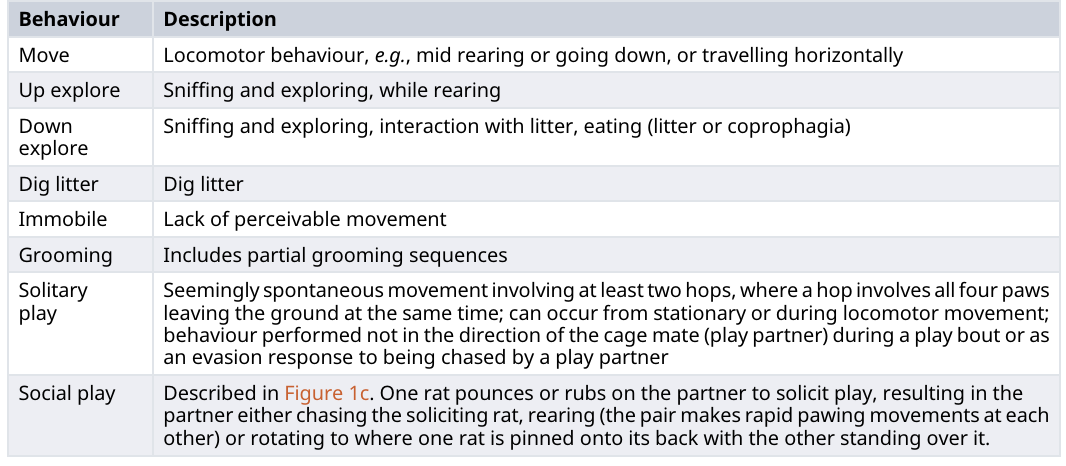
Table1.Ethogramforstudyofanticipatorybehaviour(basedonourpreviousstudiesandtakenfromBombail et al. (2019), Champeil-Potokar et al. (2021) and Hammond et al. (2019). Behaviour